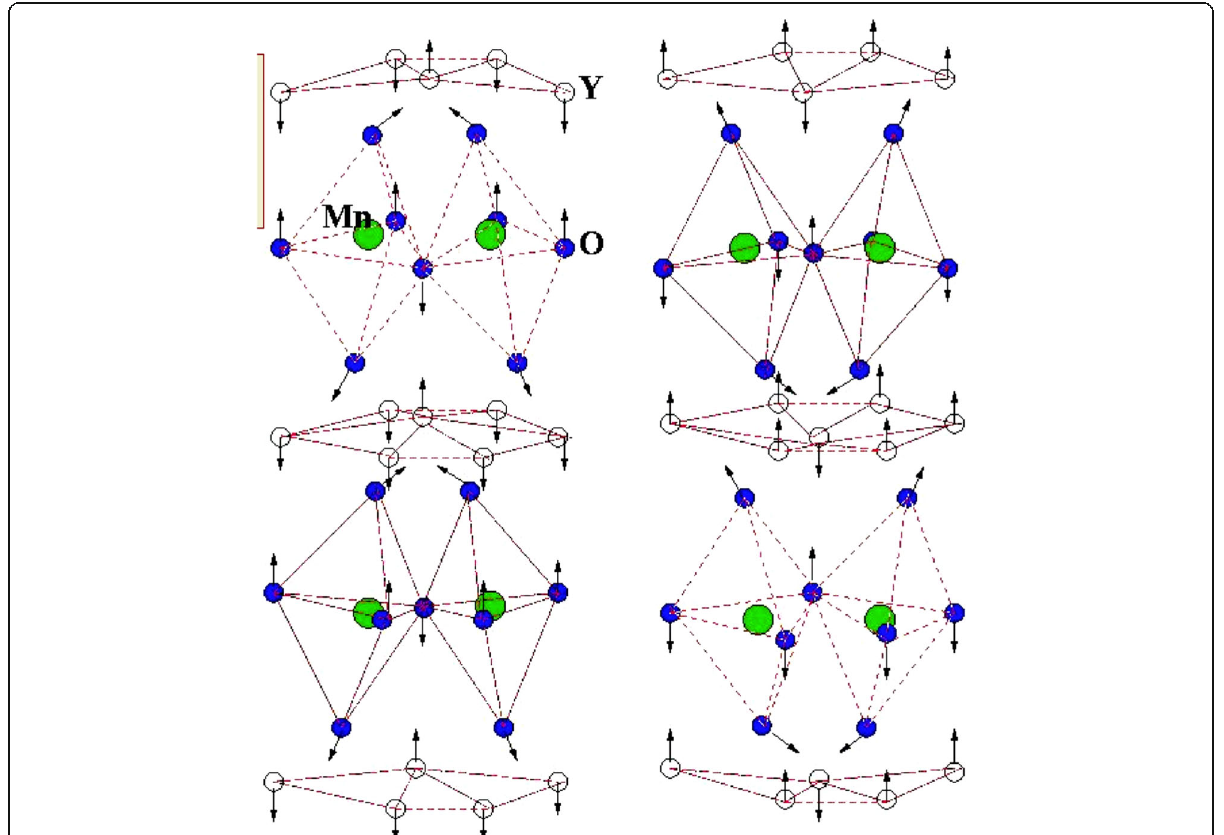
Fig. 6 Three-dimensional schematic view of YMnO 3 in the polarized states. Adapted from Spaldin et al.